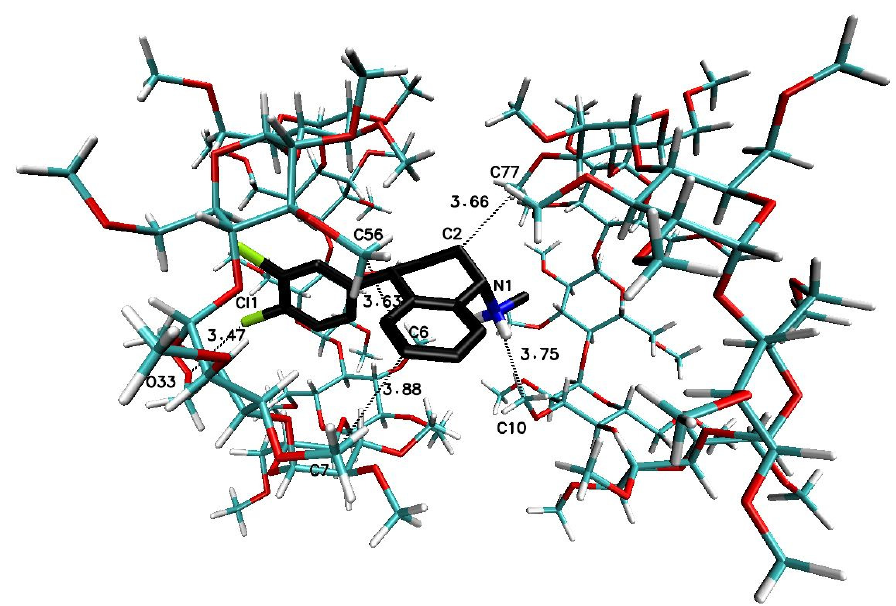
Figure 10. The geometries of the SRT-TM β CD complex with stoichiometry 1:2 (I-II or “head-to- head” [69,70]) obtained by MD simulations with the use of TM β CD crystal structure with refcode ALIGAE [68] from the CSD database [47].